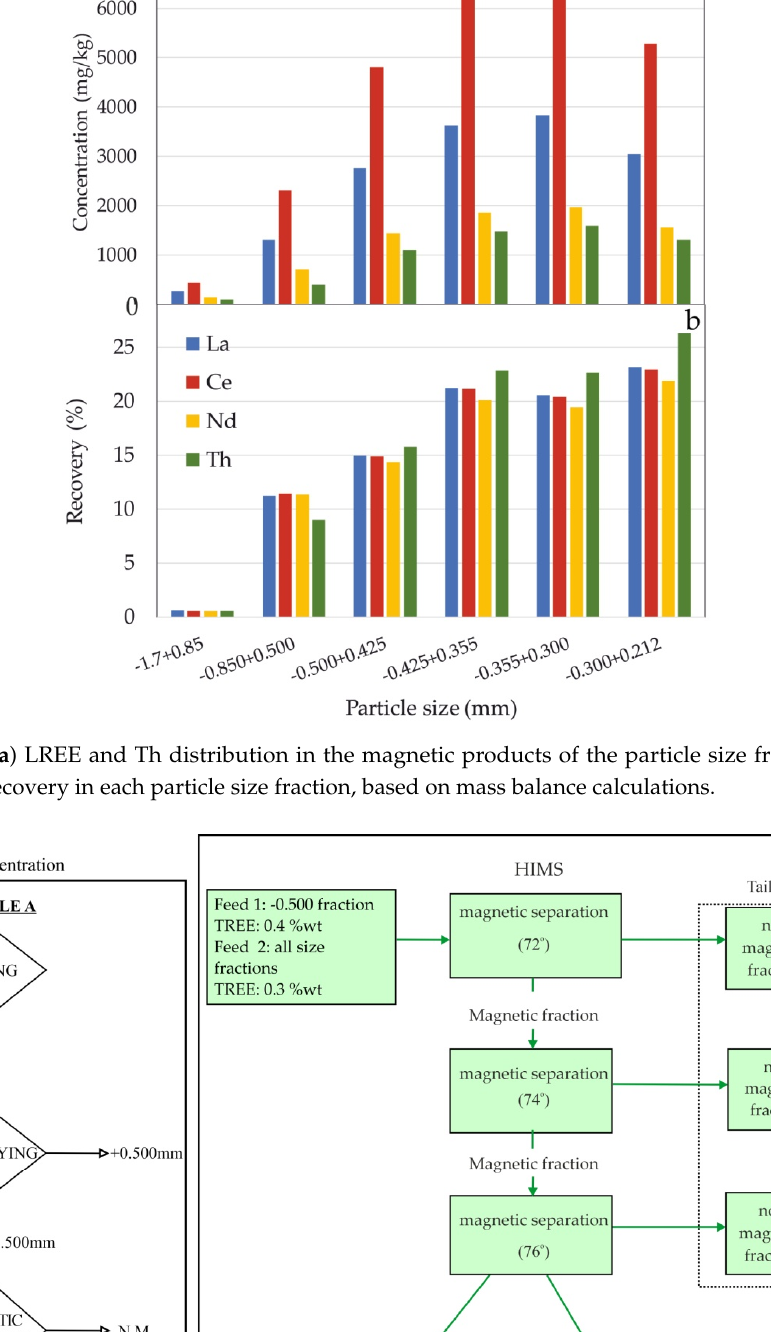
Figure 6. Comparison of XRD patterns of magnetic and nonmagnetic separates after high-intensity magnetic separation (HIMS) from sample #123. Note that the clear peaks of allanite are absent in the nonmagnetic fraction.